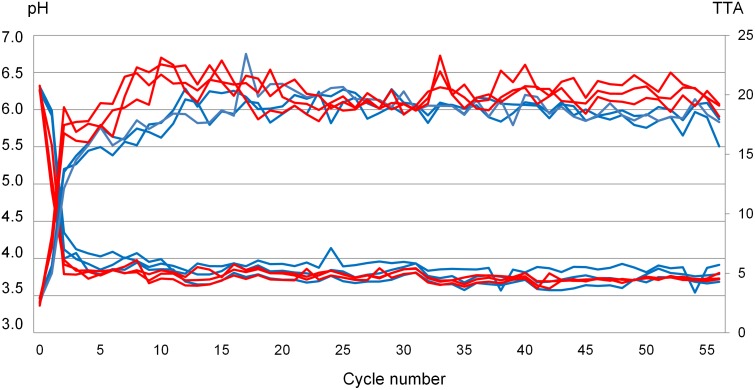
pH and total titratable acidity of six rye sourdoughs propagated at 20°C (20-I, 20-II and 20-III, shown in blue) and 30°C (30-I, 30-II and 30-III, shown in red) during 56 days.